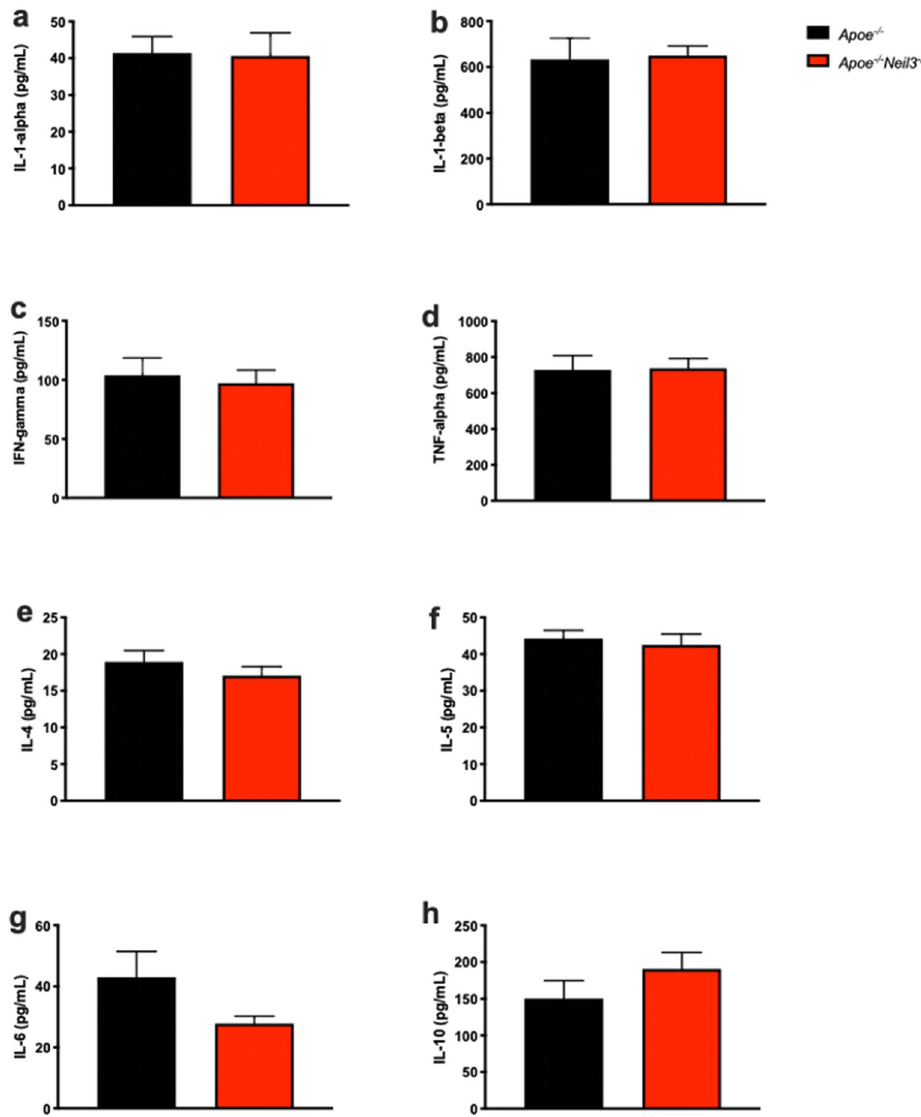
Figure 6. Non-significant difference of plasma cytokine levels between Apoe −/− Neil3 −/− mice and Apoe −/−